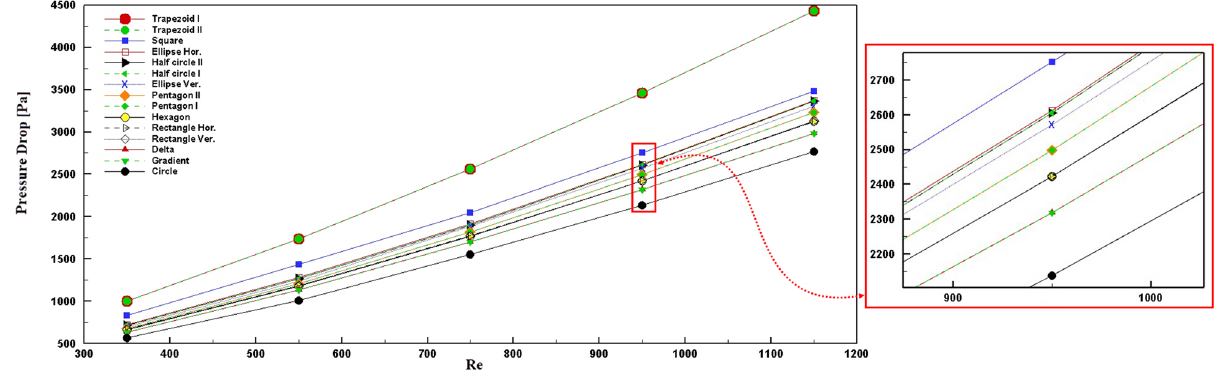
Figure 7. Pressure drops for different cross-sections of microchannel at different Reynolds numbers.